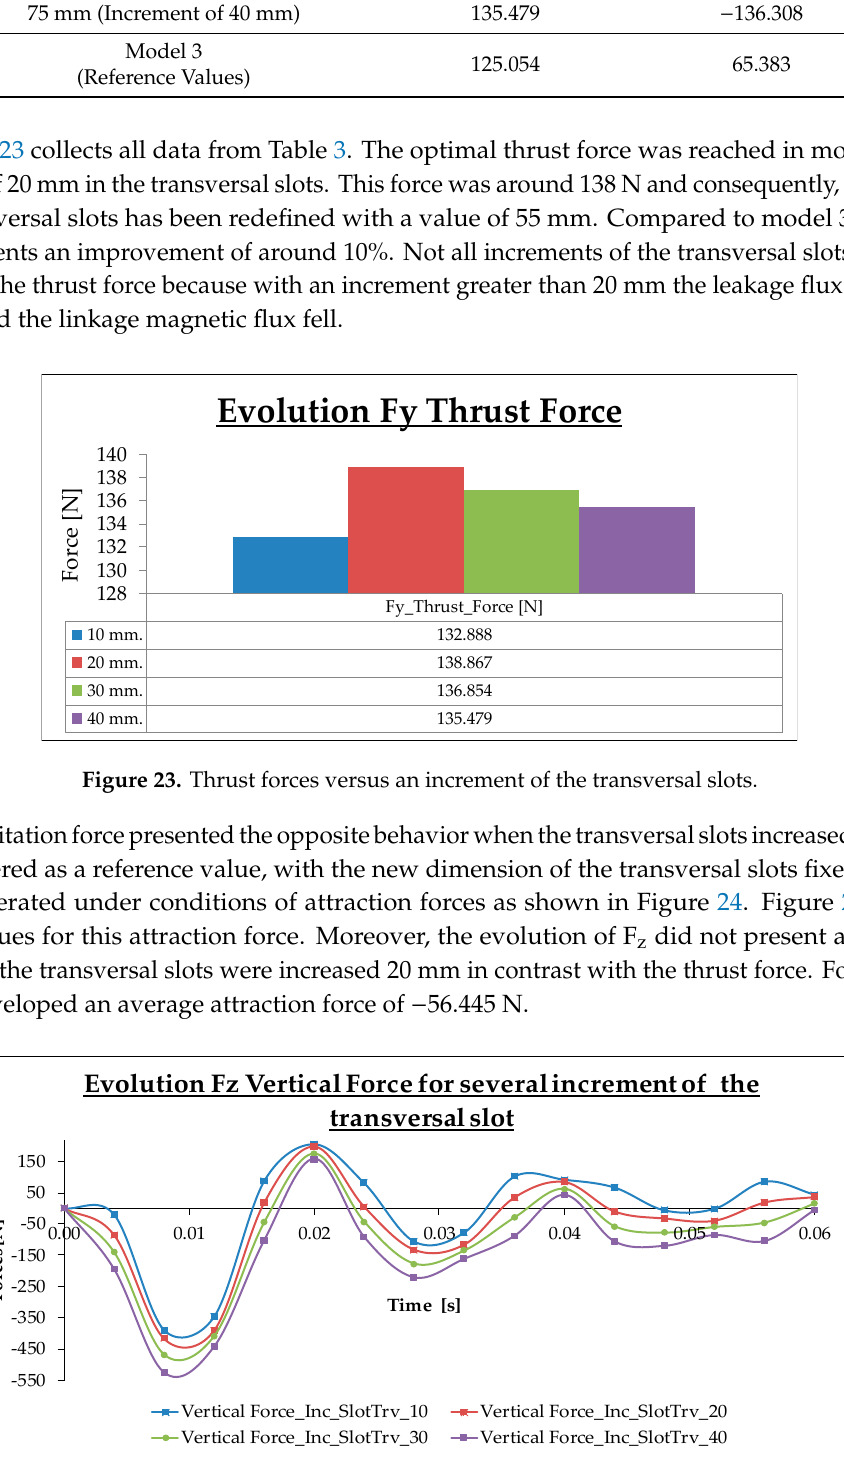
Figure 24. Levitation force in the transitory state with different values of the transversal slots.